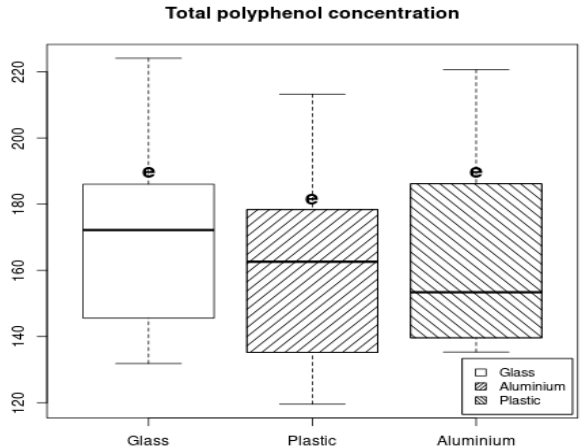
Figure 5. The box plot of total phenolic content (mg GAE/L). According to ANOVA test, the signifi- cant difference between the means for each type of container is marked by different letters ( p <